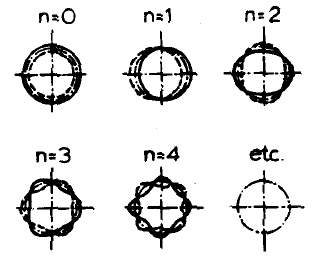
Fig. 2. Mode shape representation of cylindrical